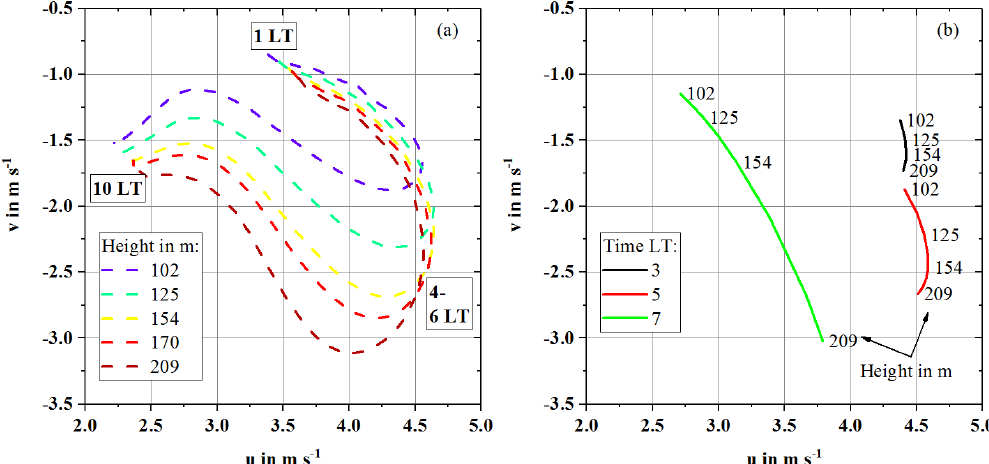
Figure 3. Hodographs (wind components u and v of the horizontal wind vector) simulated by HIRVAC2D for a cloudless summer day (19 June) at several times (a) between 01:00 and 10:00LT (Local Time) and at several heights (b) over a homogeneous grassland site for vg = 4ms − 1 .